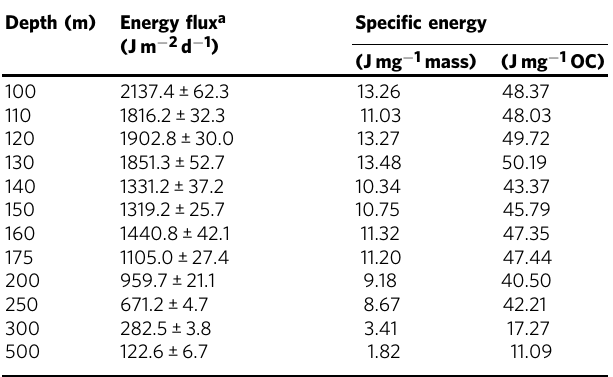
Table 2 Total energy fl uxes and speci fi c energy of sinking particulate